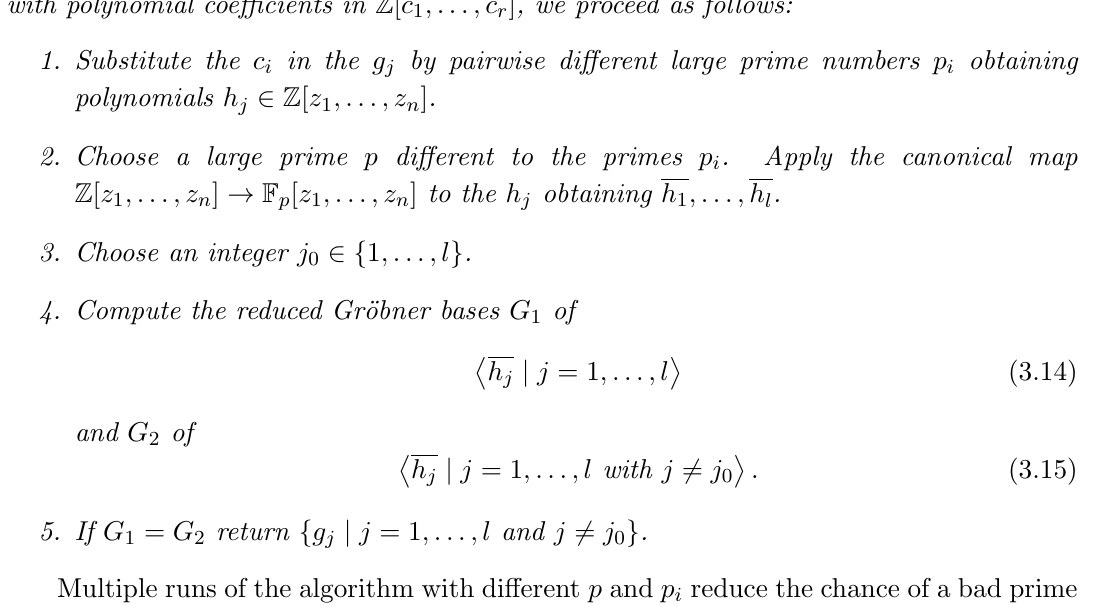
Algorithm 8 (Trimming) . Given a generating system g with polynomial coe(cid:14)cients in Z [ c